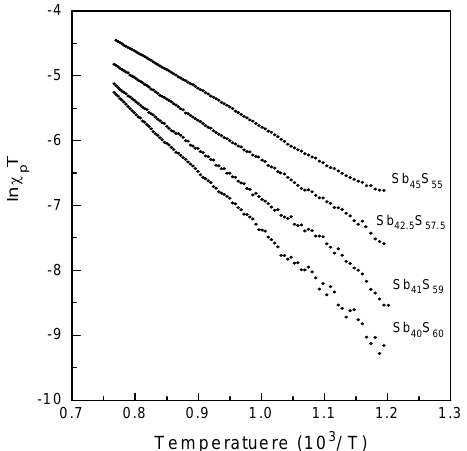
Fig. 8. Linear relation in ln χ p T - T -1 plot suggests a Curie type temperature dependence of the magnetic